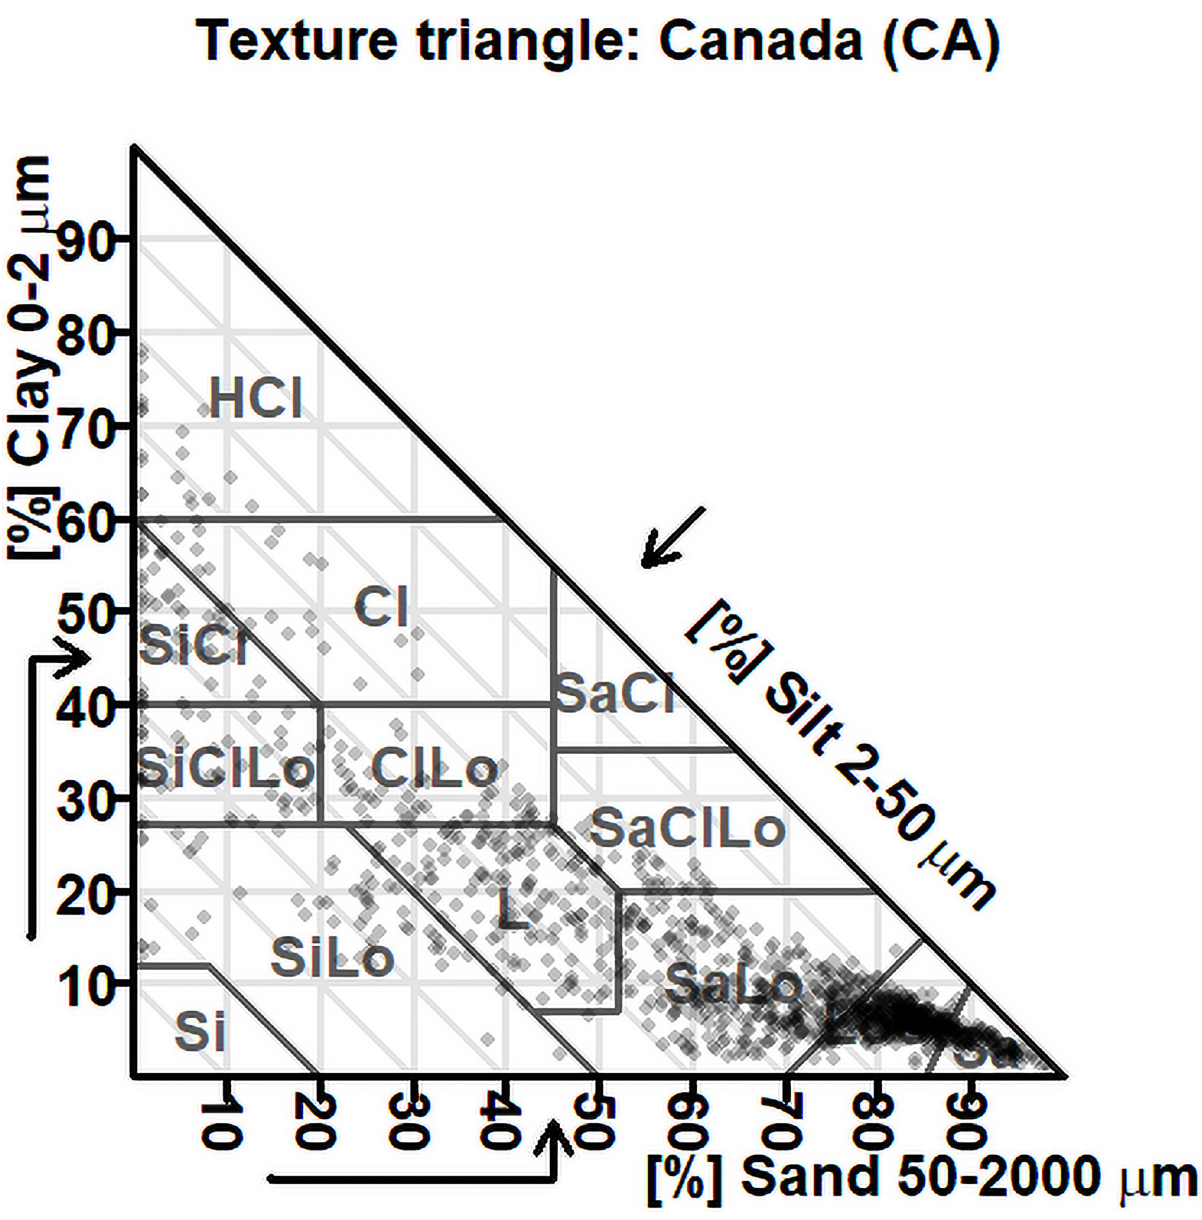
Fig 2. Particle size distribution of studied soils in the Canadian textural